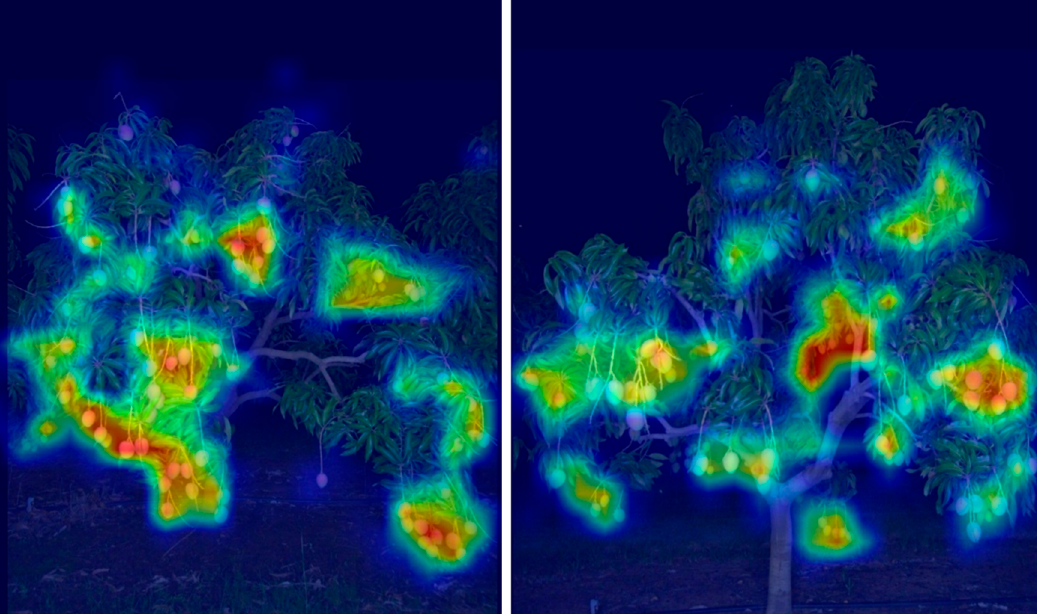
Figure 8. Grad-CAM visualization of activation map of the final convolution layer of Xception_count model trained to directly predict fruit count on input images. Example given are images from two sides of one tree.